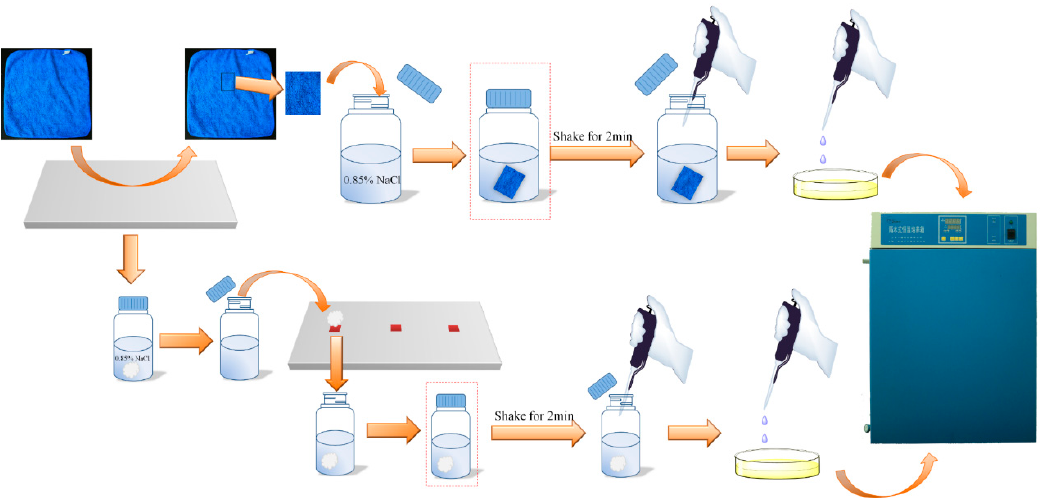
Figure 3. A scheme of the wiping test procedure.